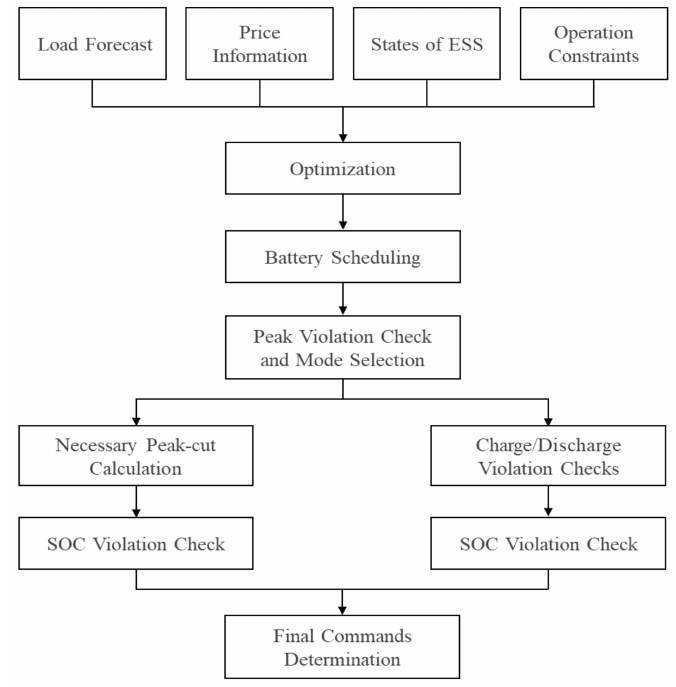
Figure 4. Optimal scheduling process for energy storage system in field